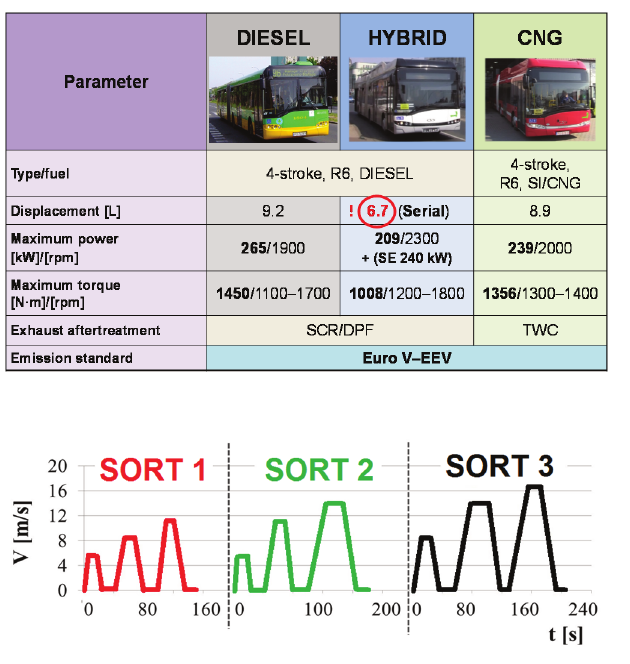
Tab. 2. Technical characteristics of vehicles used for tests